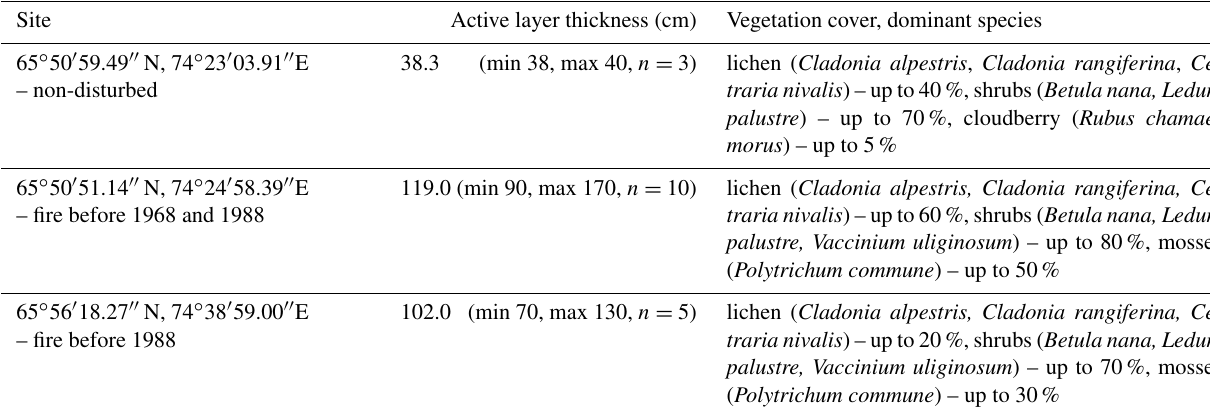
Table B1. Field observations of vegetation and active layer thick-